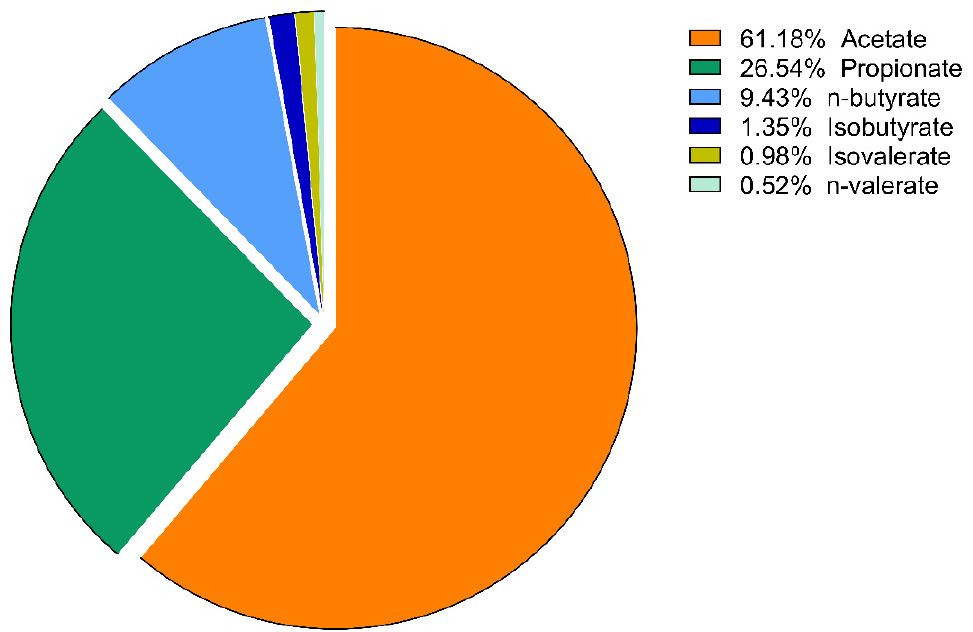
Figure 5. Volatile fatty acid profile of fecal samples of the lactulose group on day 0 of the experiment measured by GC-MS method. Data are expressed as mol%.